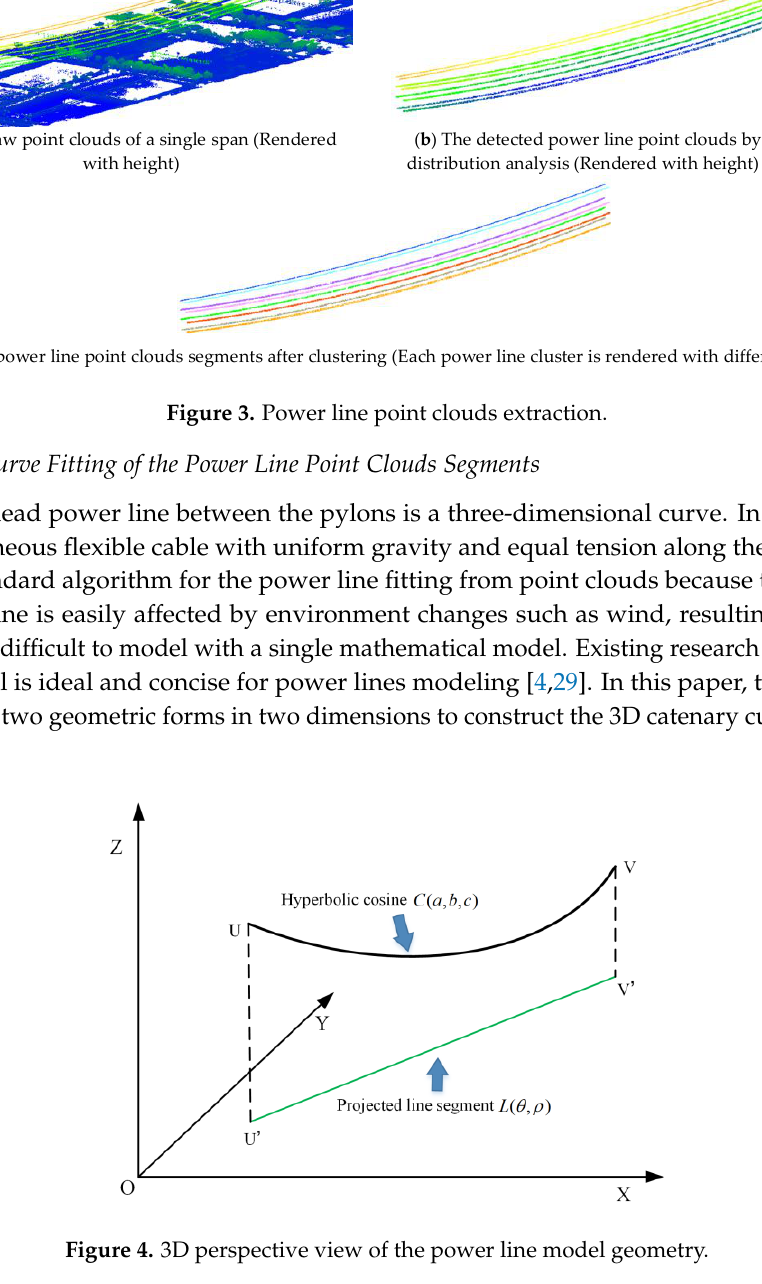
Figure 4. 3D perspective view of the power line model geometry.